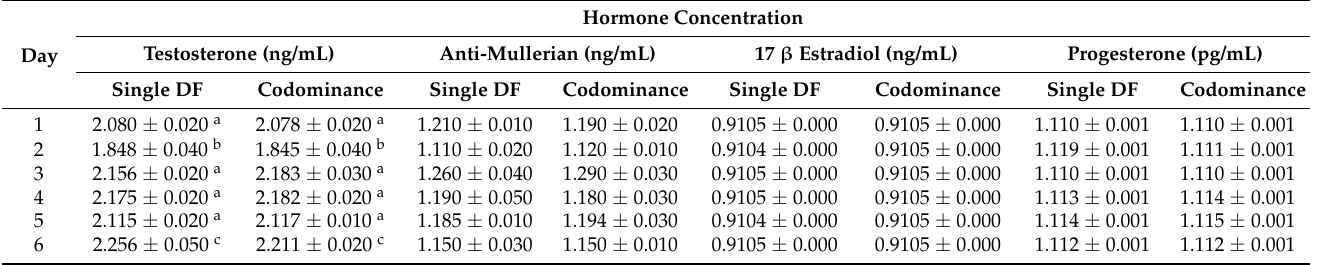
Table 5. Hormone concentration profiles during the follicular deviation process in llamas (